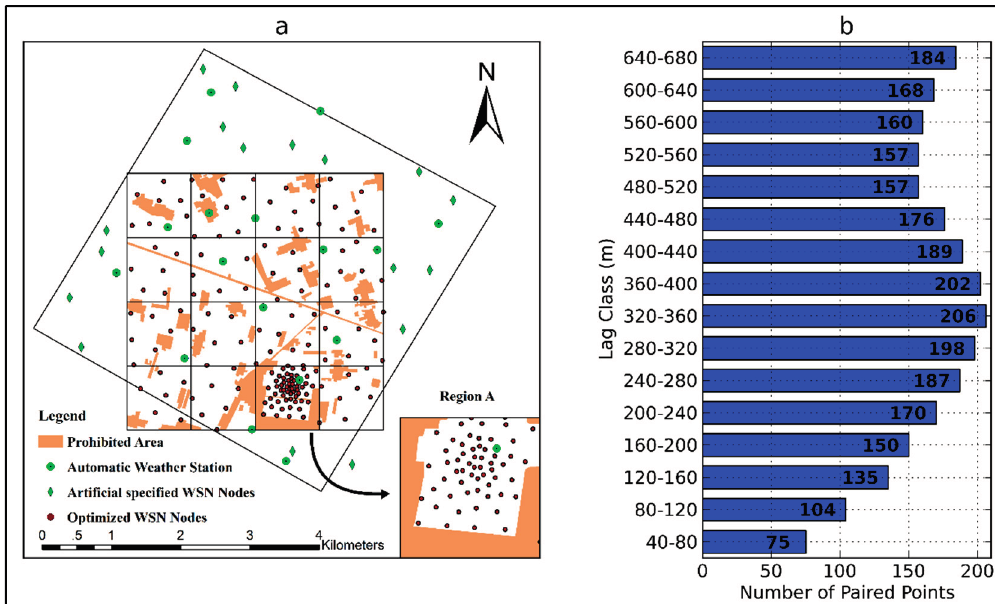
Figure 6. Optimized distribution of EHWSN nodes in the observation matrix ( a ) and the number of paired points in each lag class ( b